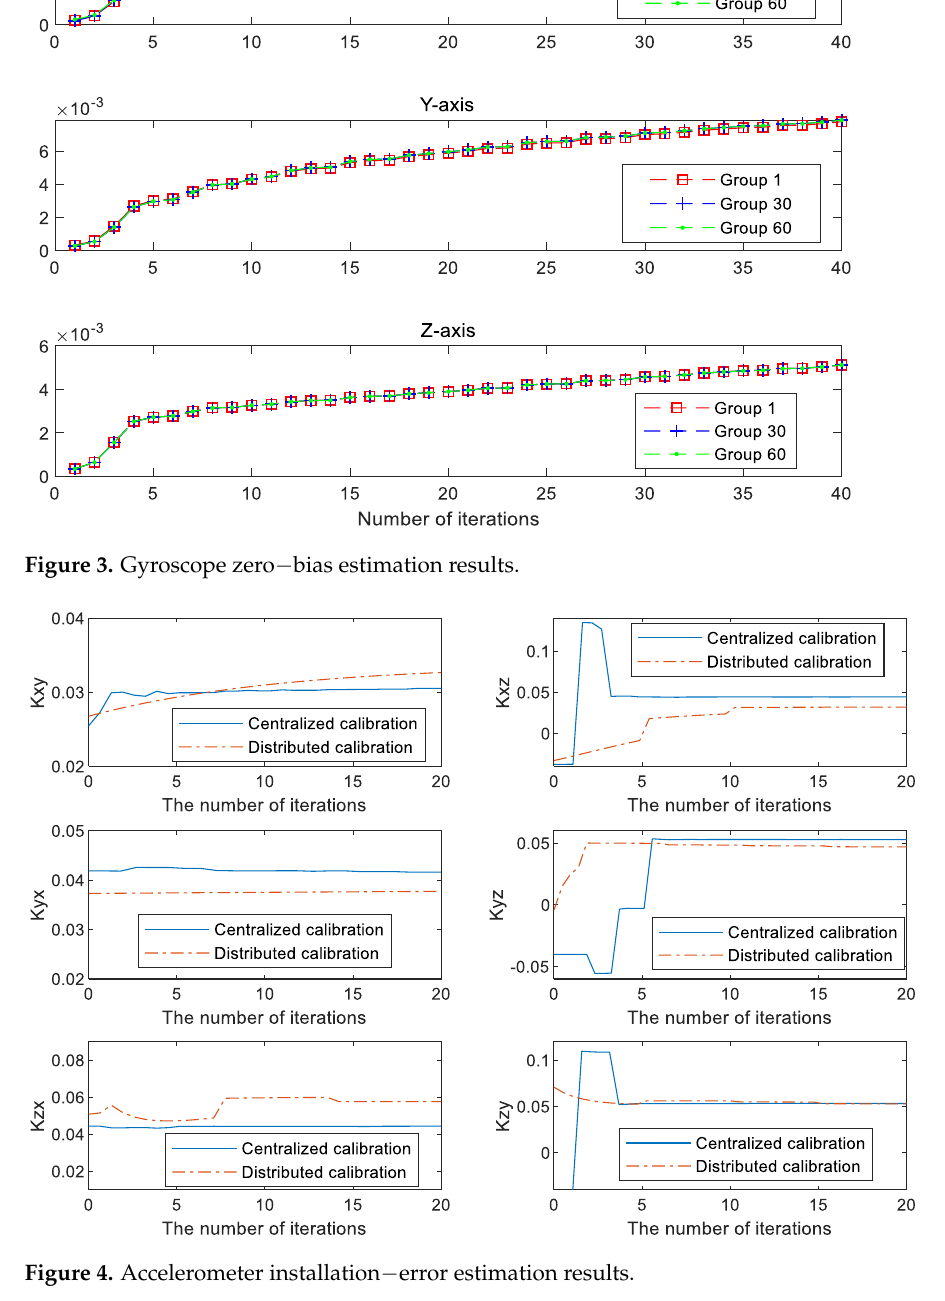
Figure 4. Accelerometer installation − error estimation results.